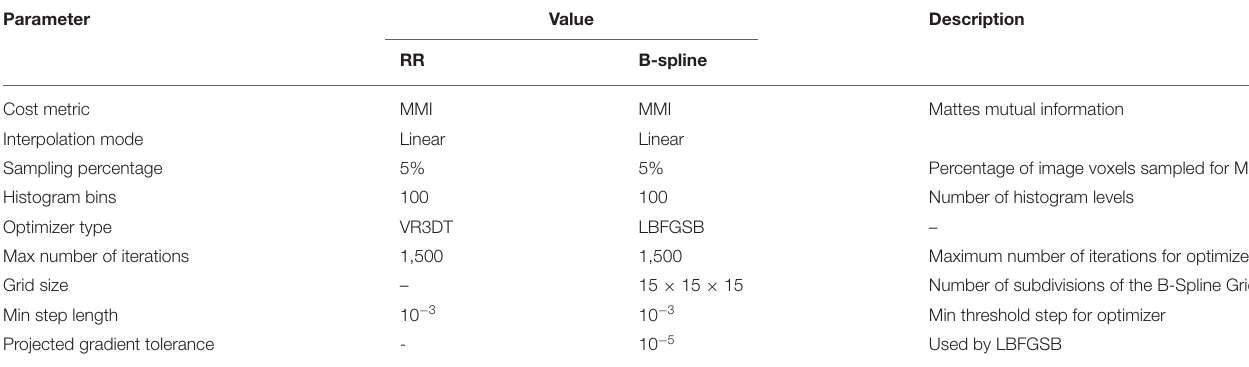
TABLE 2 | Parameters used in this study for rigid registration (RR) and B-Spline non-rigid registration methods implemented in 3D Slicer. Parameter Value Description